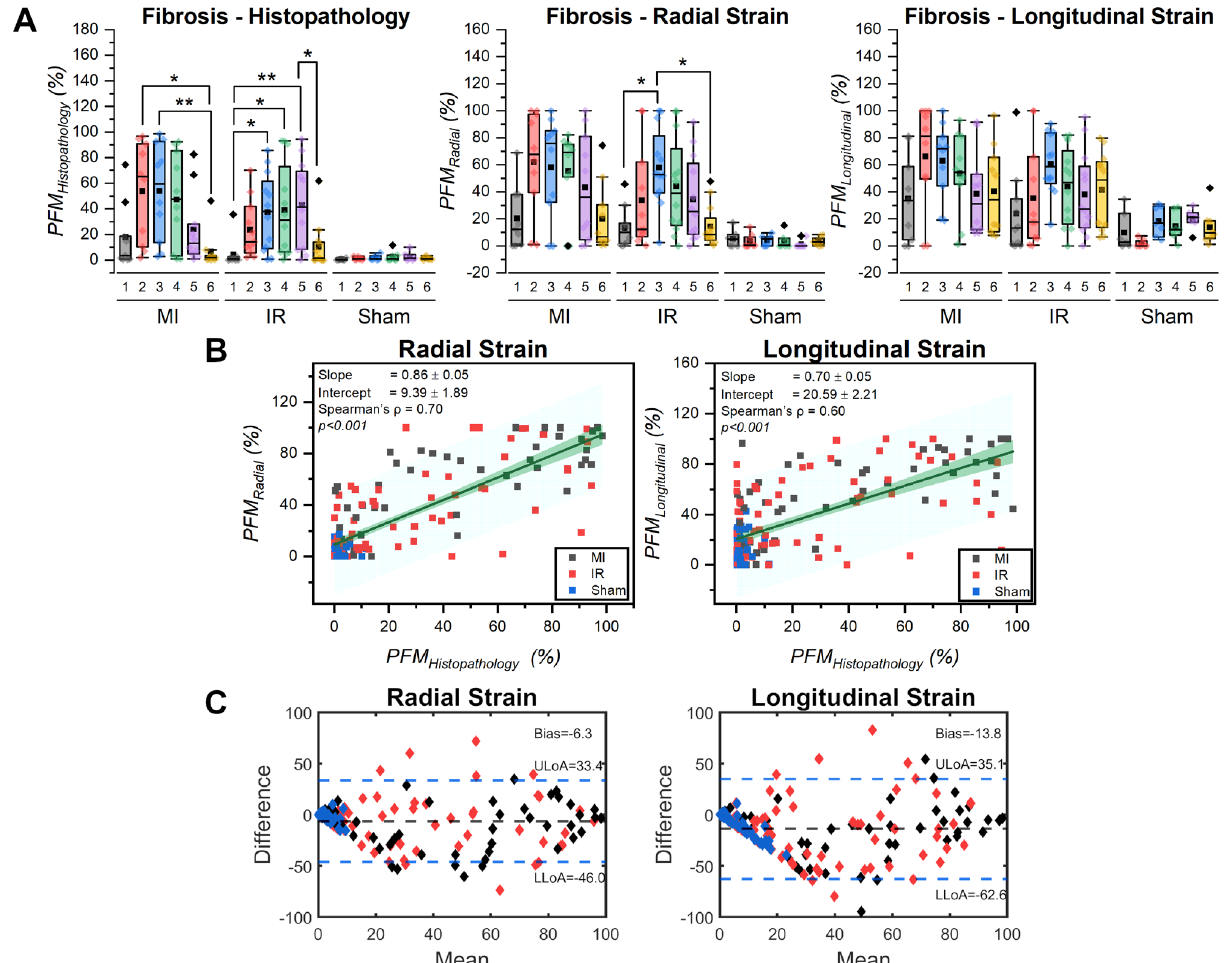
Figure 5. Quantitative comparison between cardiac fibrosis maps estimated using strain images in vivo and WSI data ex vivo . ( A ) From left to right: Box and whisker plots demonstrating regional variation and inter- group comparison [MI (n = 10), IR (n = 13) and Sham (n = 8)] of PFM estimated from histopathology WSI data ( PFM Histopathology ), radial strain images ( PFM Radial ) and longitudinal strain images ( PFM Longitudinal ) respectively. Symbol definitions: 1—Anterior Base, 2—Anterior Mid, 3—Anterior Apex, 4—Posterior Apex, 5—Posterior Mid, 6—Posterior Base, Squares—mean, Diamonds—outliers, whiskers—1.5 × IQR (Inter-quartile range), box— 25th to 75th percentiles. Kruskal–Wallis test with Bonferroni–Dunn test post hoc test was used. ( B ) Left panel: Correlation and linear regression analysis of PFM Radial against PFM Histopathology (n = 172). Right panel: Correlation and linear regression analysis of PFM Longitudinal against PFM Histopathology (n = 172). Linear regression slope and intercept, Pearson’s correlation coefficient and p- values are shown in upper left corner of each figure. ( C ) From left to right: Bland–Altman analyses for PFM Radial and PFM Longitudinal results, respectively. Difference axes denote Histopathology PFM–Strain PFM (either radial or longitudinal). Black and blue dotted lines show the best estimate of bias and its limits of agreement (LoA) respectively. Symbol definitions: Blue diamonds—sham, Red diamonds—IR, Black